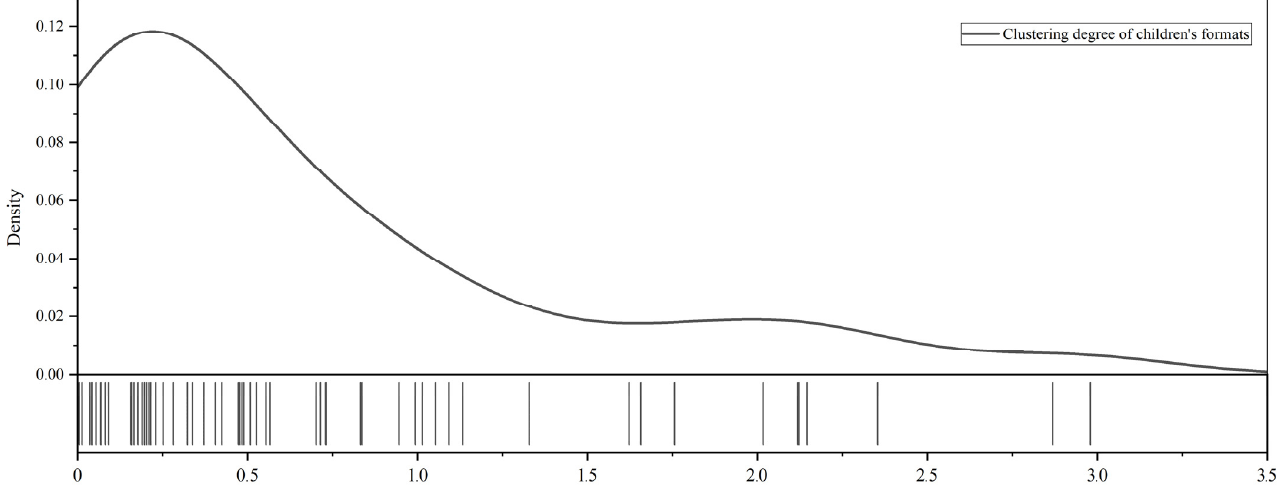
Figure 3. Kernel density estimation of clustering degree of children’s business format in Wuhan’s commercial centers. Data sources: the field investigation data.